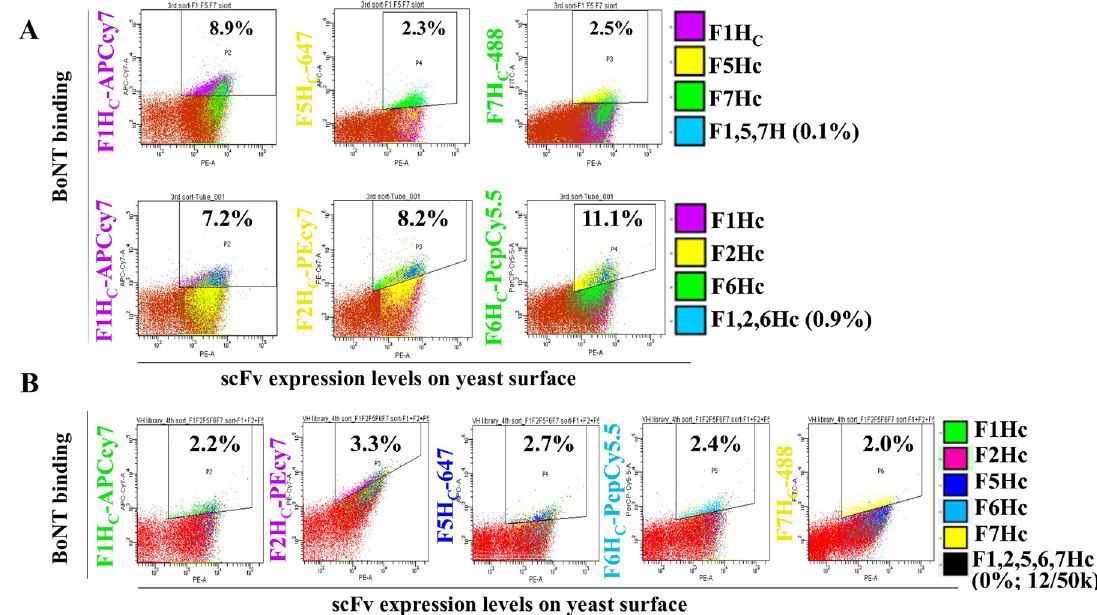
Fig 4. Dot plots of FACS of the mAb 28H4E10 scFv yeast displayed library using multi-color staining. A. For the third round of sorting, the scFv library was stained with a mixture of either BoNT subtypes BoNT/F1H C -APCcy-7, BoNT/F5H C -Alexa647, and BoNT/ F7H C -Alexa488 or BoNT subtypes BoNT/F1H C -APCcy-7, BoNT/F2H C -PEcy7, and BoNT/F6H C -Pepcy5.5. Each dot represents a single yeast with the BoNT subtype used for staining and the BoNT binding fluorescence shown on the y-axis and the level of scFv yeast surface display on the x-axis. The population gated for sorting and the percent of the total population sorted is shown with the gated yeast colored according to the legend for each of the BoNT subtypes. For sorting the three gates were intersected and only yeast in all three gates (colored blue and with the percent of yeast in the intersected yeast indicated) were collected. B. For the fourth round of sorting, the scFv library was stained with a mixture of BoNT subtypes BoNT/F1H C -APCcy-7, BoNT/F2H C -PEcy7, BoNT/F5H C -Alexa647, BoNT/ F6H C -Pepcy5.5, and BoNT/F7H C -Alexa488. Each dot represents a single yeast with the BoNT subtype used for staining and the BoNT binding fluorescence shown on the y-axis and the level of scFv yeast surface display on the x-axis. The population gated for sorting and the percent of the total population sorted is shown with the gated yeast colored according to the legend for each of the BoNT subtypes. For sorting the five gates were intersected and only yeast in all five gates (colored blue and with the percent of yeast in the intersected yeast indicated) were